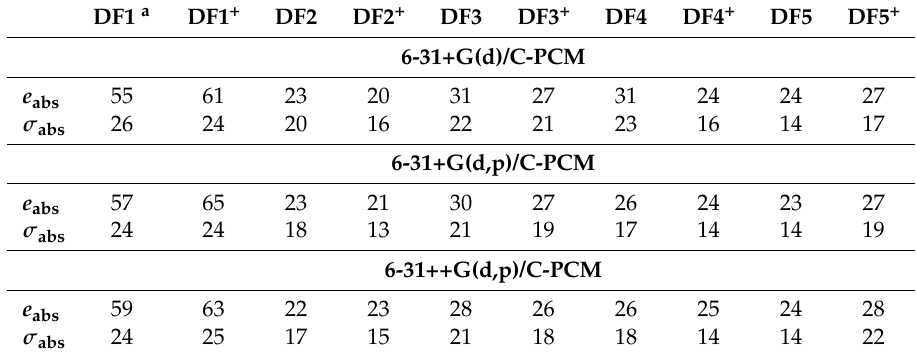
Table 3. Mean absolute errors ( e abs ) and standard deviation of absolute errors ( σ abs ) for theoretical values of 12 investigated nitroaromatic MBHA calculated at DFT level with C-PCM continuum solvation model from direct protocol. Values are in millivolts. DF1 a